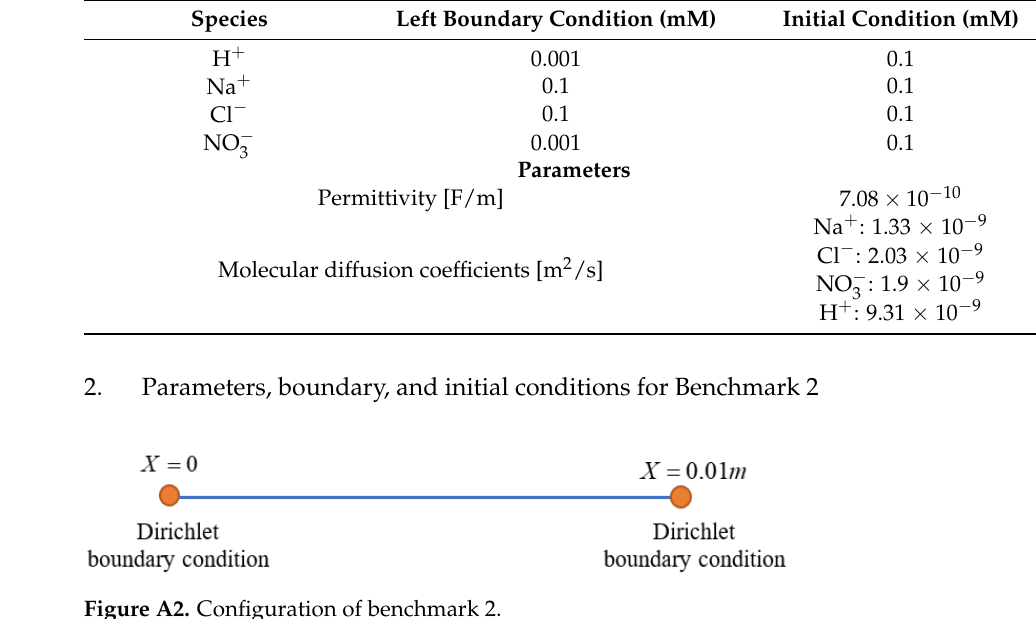
Table A1. Boundary and initial conditions, chemical system, and parameters for benchmark 1.